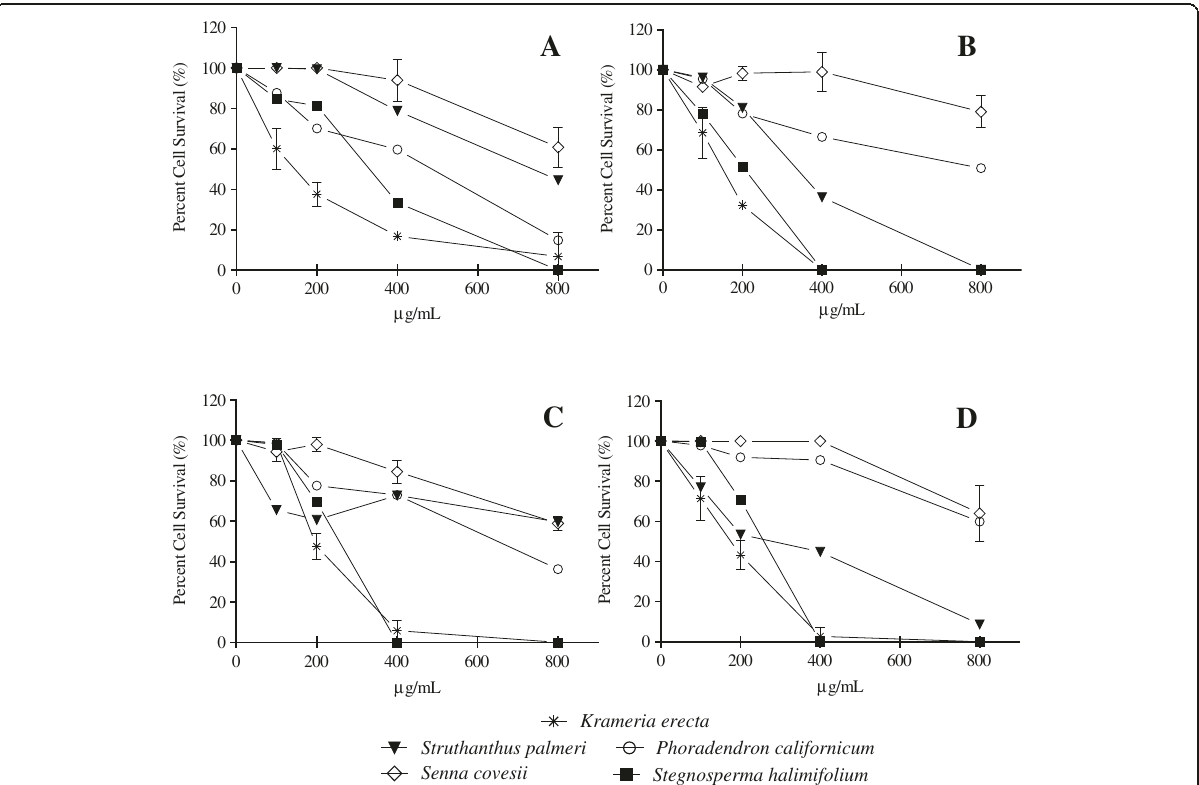
Figure 4 Antiproliferative activity of the extracts on A) HeLa, B) RAW 264.7, C) M12A k .C3.F6 and D) L929 cells of Krameria erecta , Struthanthus palmeri , Phoradendron californicum , Senna covesii and Stegnosperma halimifolium methanolic extracts. The bars represent the standard deviation (mean ± SD; n =